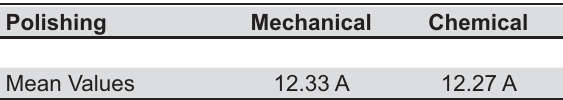
Means followed by the same capital letter do not differ